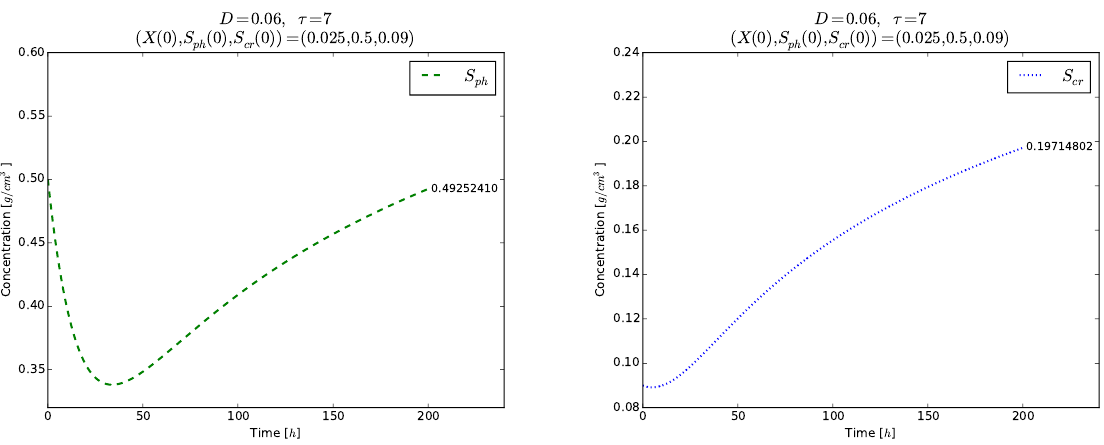
Figure 8. Example 3. Global stability of the equilibrium point E 0 ( left ). Time evolution of X ( t ) for t ∈ [ 0,200 ] ( right ).